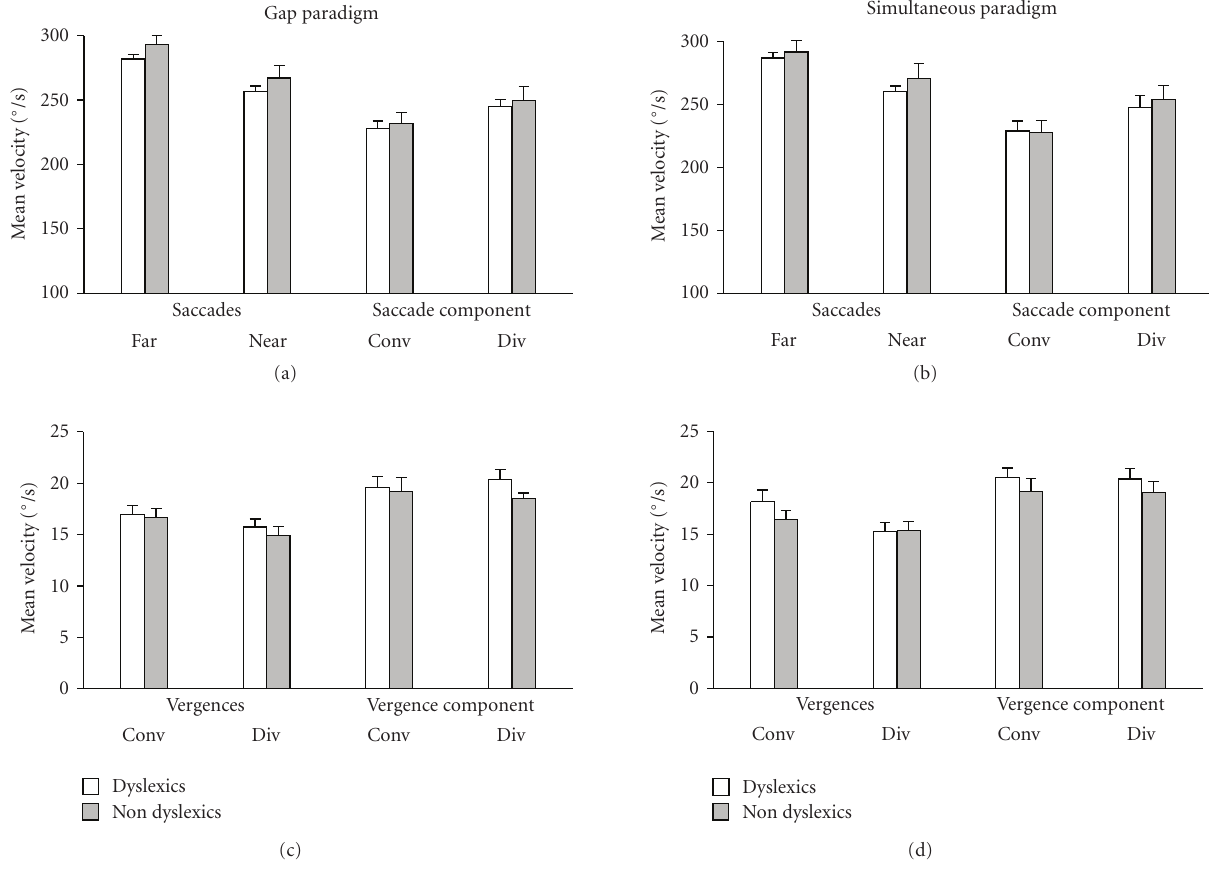
Figure 2: Mean velocity (amplitude of the movement/duration) of di ff erent types of eye movements in the gap (a) and (c) and in the simultaneous paradigm (b) and (d) for dyslexic (white bars) and non-dyslexic reader (gray bars) children. Vertical lines indicate standard